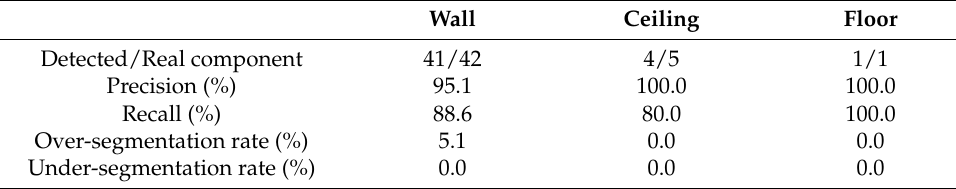
Table 5. Experiment results of Dataset #3.